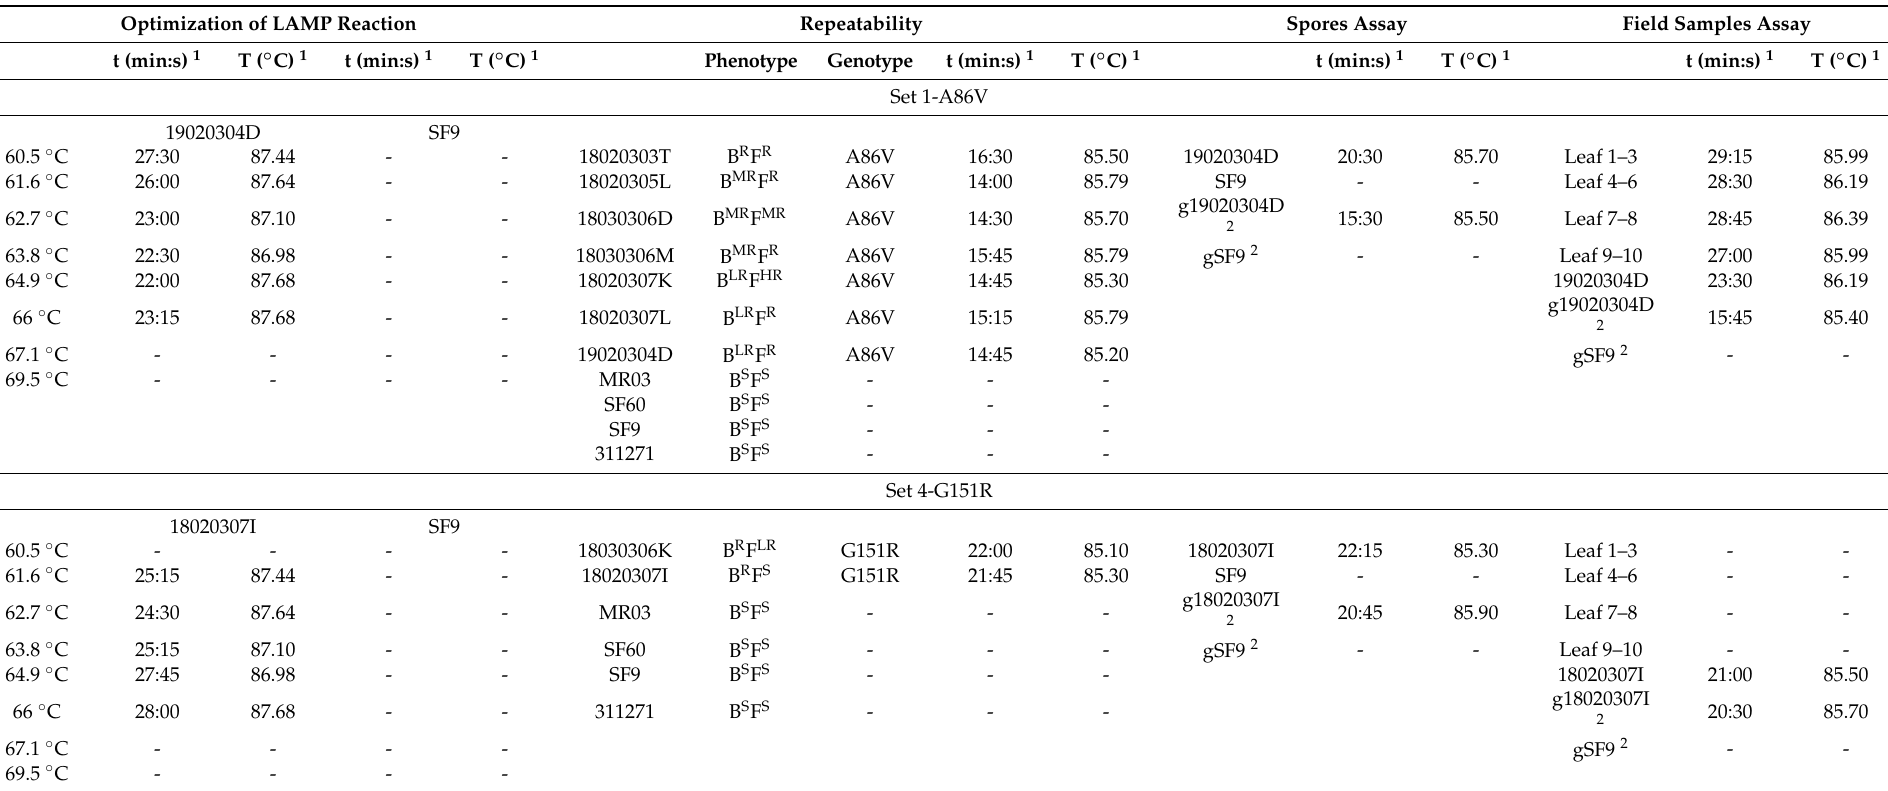
Table 6. Tests and results of LAMP assay for detecting the amino acid changes A86V and G151R in P. xanthii . Optimization of LAMP Reaction Spores